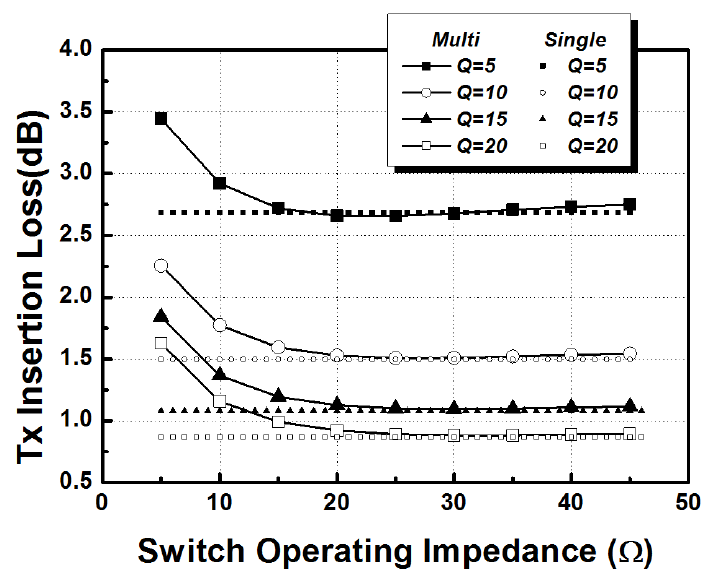
Figure 10. Total loss of the antenna switches with a multi-section (scatter and line) and single-section (scatter) matching network in Tx mode.